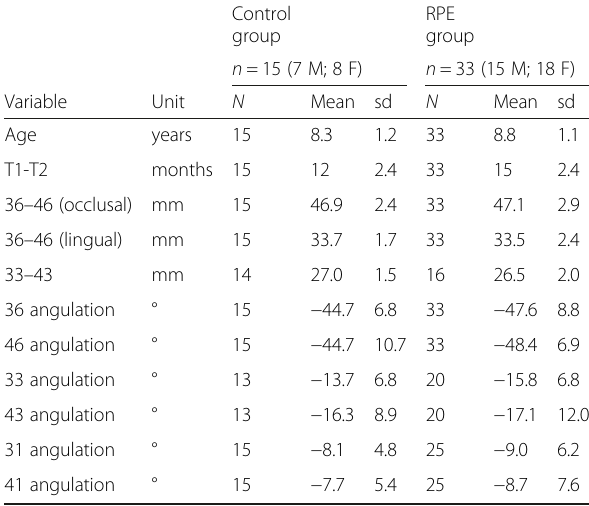
Table 1 Descriptive statistics and comparisons between groups at